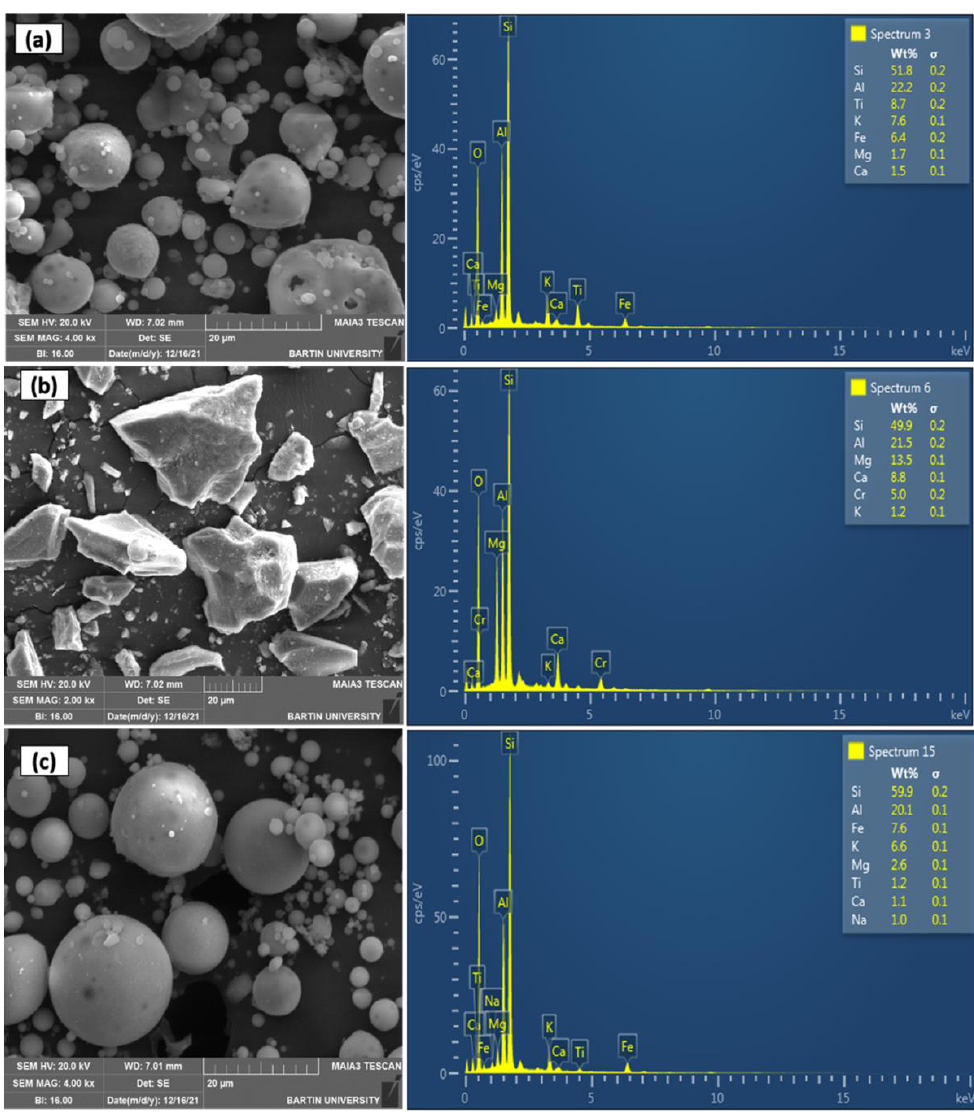
Figure 4. SEM and EDX analysis of ( a ) FA, ( b ) FS, and ( c ) SF.